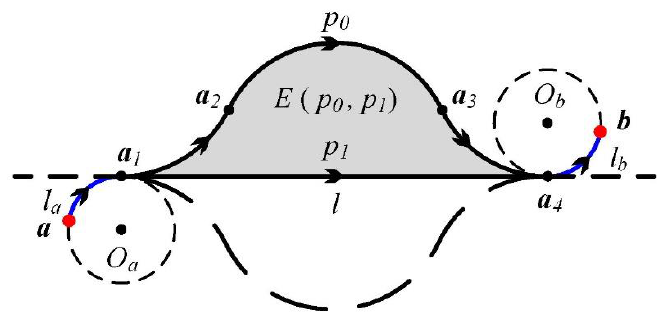
Figure 6. Path homotopy 1.